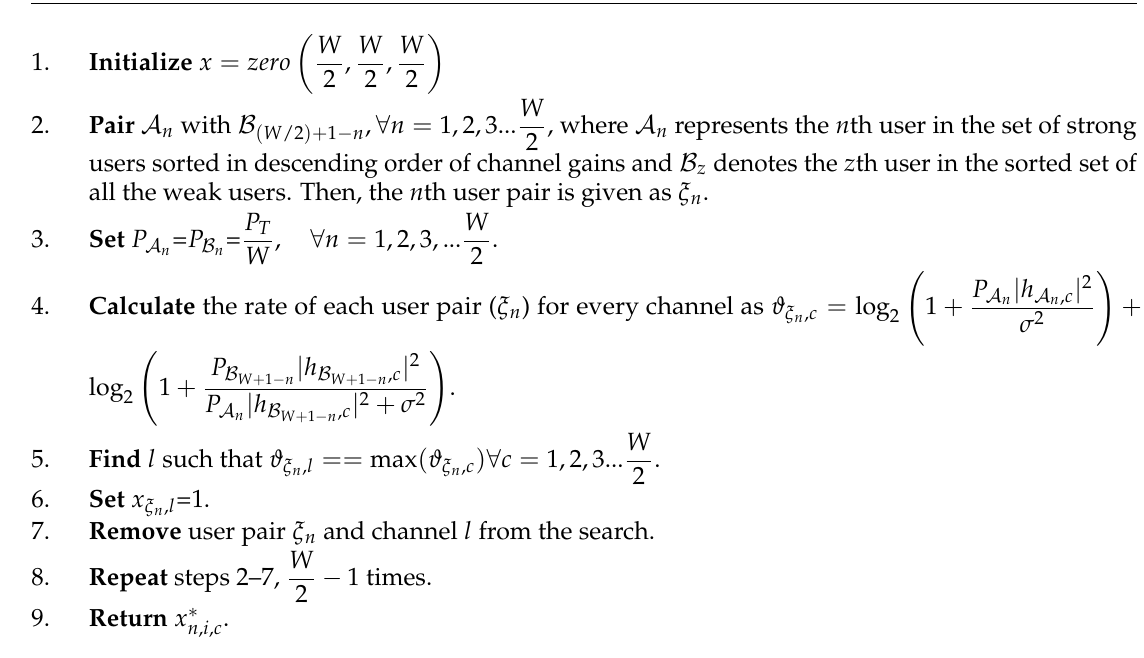
Algorithm 1 User pairing and channel